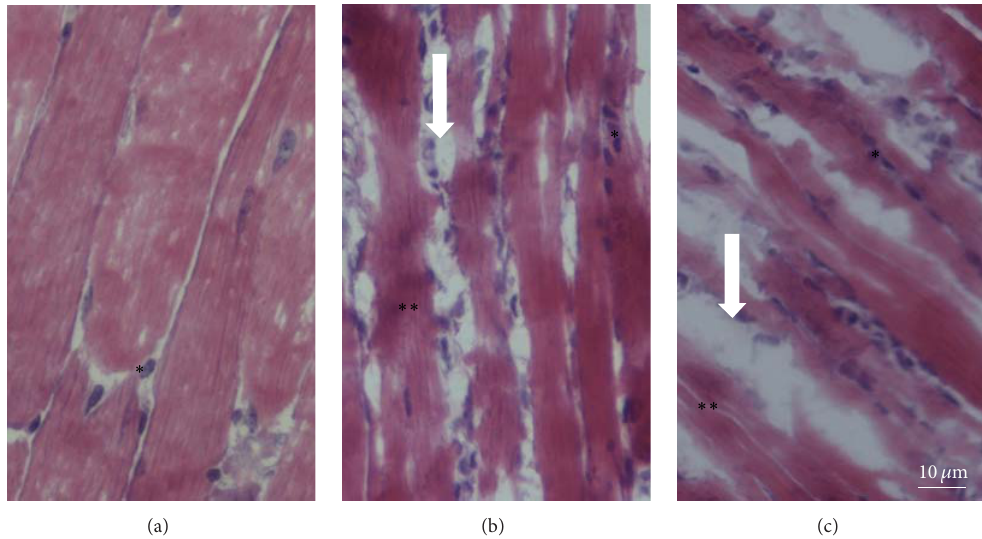
Figure 3: Light micrographs of chick biventer cervicis preparations incubated with Krebs solution (control, (a)) or incubated with BmjeTX- I (b) and BjmeTX-II (c) (10 𝜇 g/mL each). All images were obtained from longitudinal sections. Notice that in (a) the fibres are normal in appearance, while in (b) and (c) several fibres appear with disrupted myofibrils (white arrows) and hypercontracted zones throughout their length ( ∗∗ ) and nucleus ( ∗ ); HE, 𝑛 = 4 per